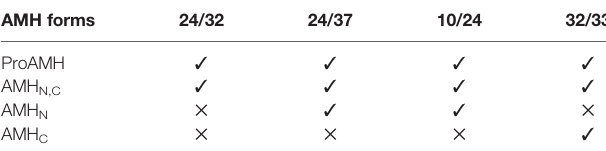
TABLE 1 | AMH isoforms detected by the four different ELISA